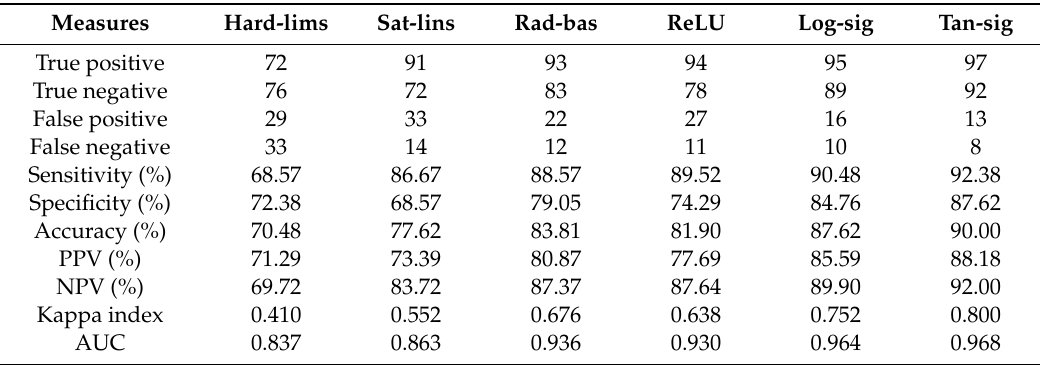
Table 4. Results of model performance